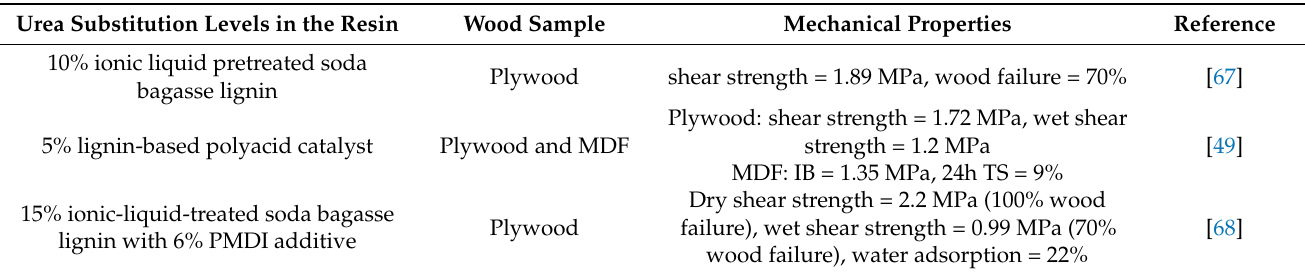
Table 2. Resin composition, sample type, and mechanical properties of selected UF resins described in literature. Urea Substitution Levels in the Resin Wood Sample Mechanical Properties